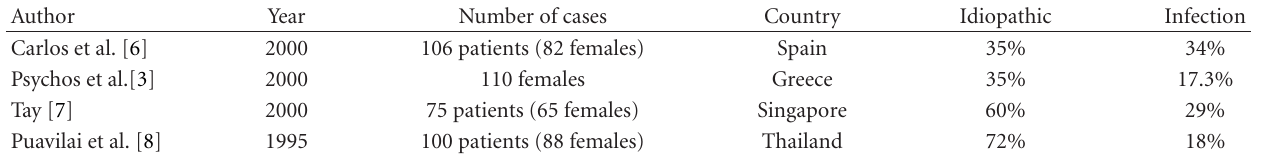
Table 2: Retrospective studies that show variation according to geographical di ff